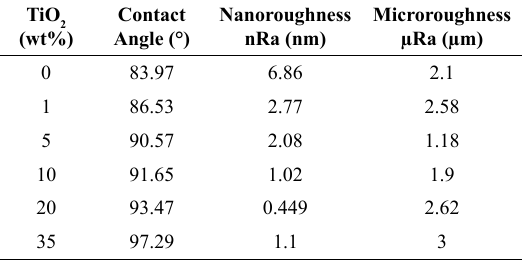
Table 2. Number of adhering bacteria on the TiO Number of Adhering Bacteria TiO 2 Staphylococcus (wt%) aureus